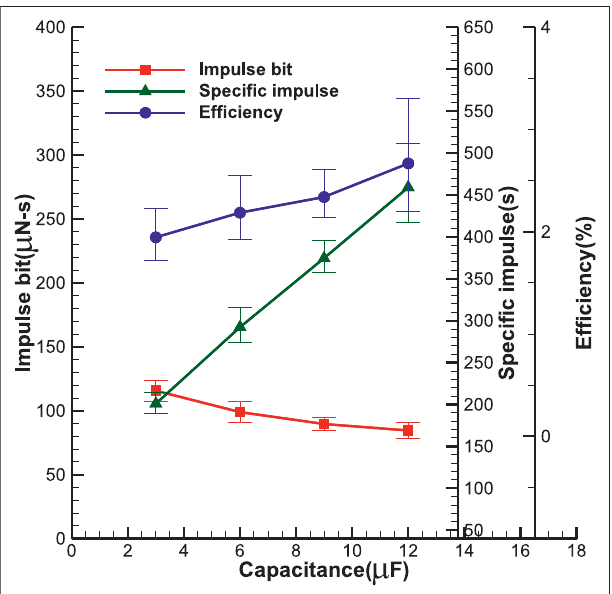
FIGURE 11 | Normalized discharge current waveform.